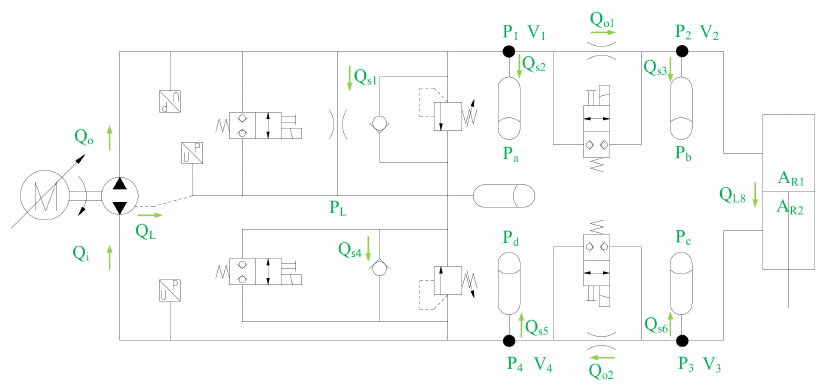
Figure 9. Schematic of